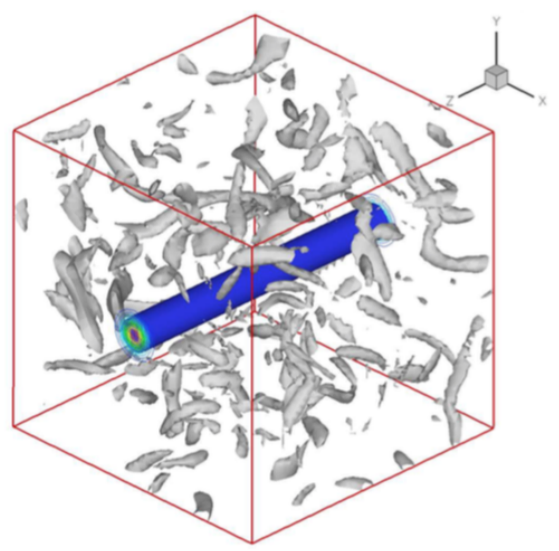
Figure 3. Arbitrary iso-surfaces of the initial species concentration (blue) in the statistically stationary turbulence (light gray). The contour lines represent the scaled concentration ( X k in Equation